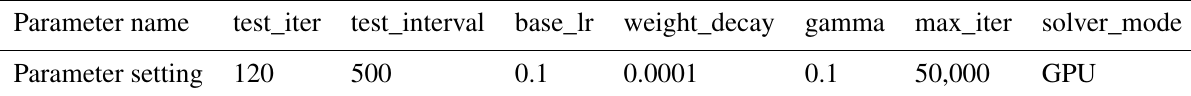
Table 1 Training parameter settings of this